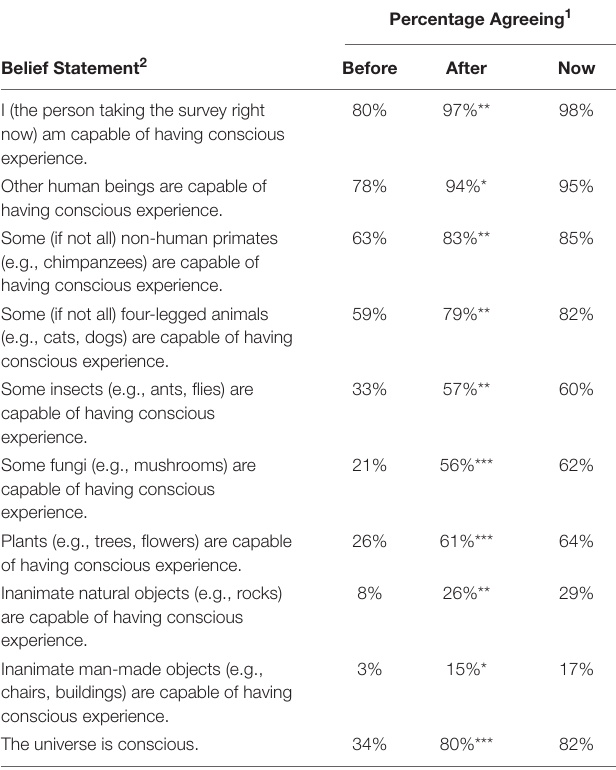
TABLE 2 | Percentage of participants endorsing agreement about beliefs in the capacity of conscious awareness in living and non-living entities ( N =